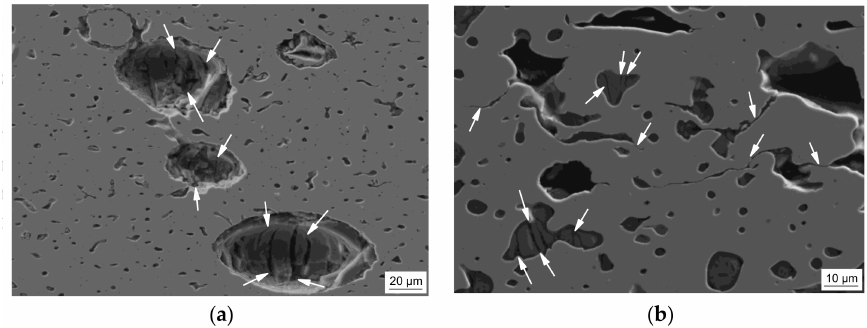
Figure 7. Failure patterns of the TRIP-steel syntactic foams at 20% strain under quasi-static compressive loading: ( a ) with 40 vol % Fillite 106 cenospheres (T4C); ( b ) with 40 vol % S60HS glass microspheres (T4G); the arrows mark the failure sites. (Load direction is vertical).